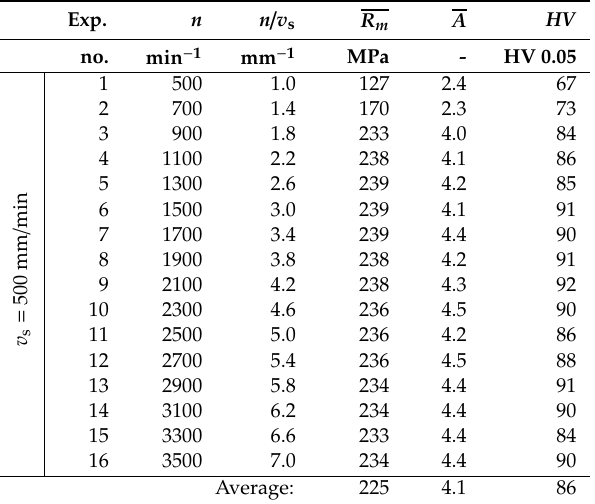
Table A1. Welding experiments performed and mechanical properties achieved for a welding speed v s of 500 mm / min. Exp. n n / v s